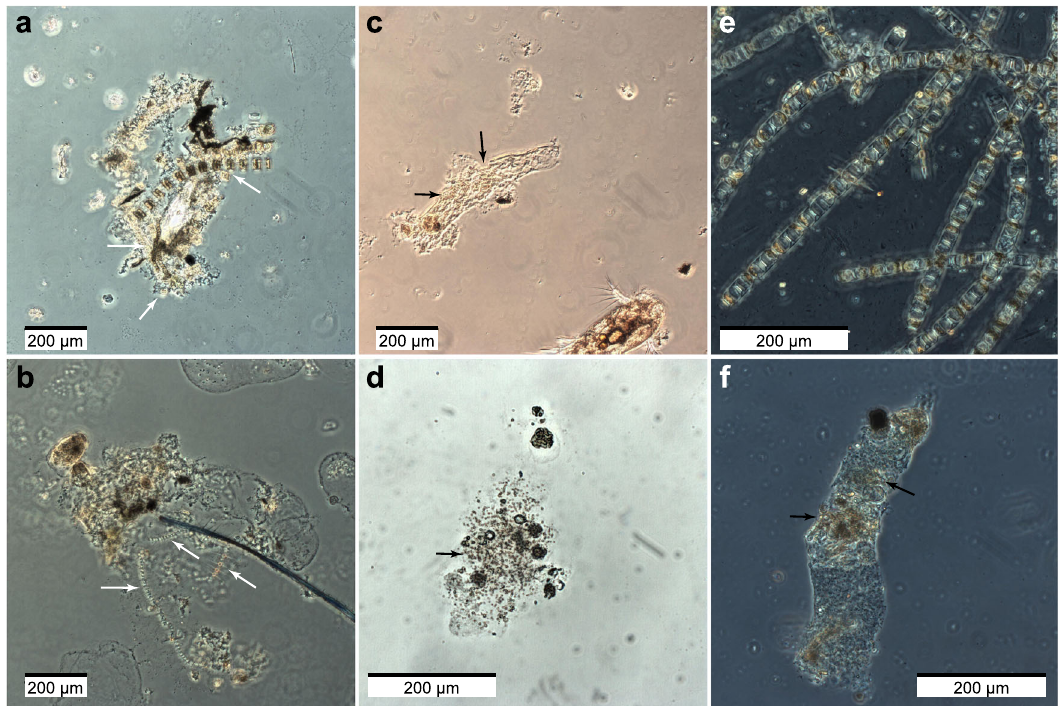
Fig. 2 Exemplary light microscopy images of marine aggregates from MSC deployments in Fram Strait. a , b Aggregates dominated by diatoms from ice- covered region - ‘ EG ’ , where ( a ) is mainly diatoms and ( b ) is diatoms together with Phaeocystis spp. c , d Aggregates dominated by fl agellates in the ice-free region - ‘ HG ’ , where ( c ) is a copepod fecal pellet composed of fl agellates and ( d ) is a marine snow aggregate formed from Phaeocystis spp. colonies. e Chains of Melosira spp., diatoms growing under the sea ice. f Calanus spp. (copepod) fecal pellets collected at the ice-covered region - ‘ N ’ and formed from mainly Phaeocystis spp. colonies with a few diatoms. White arrows point towards diatom chains and black arrows point towards colonies of fl agellates.